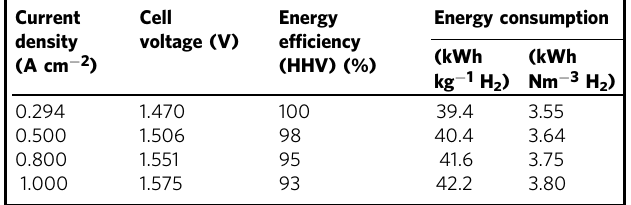
Table 2 Performance at 85 °C of the capillary-fed electrolysis cell with PTFE at the